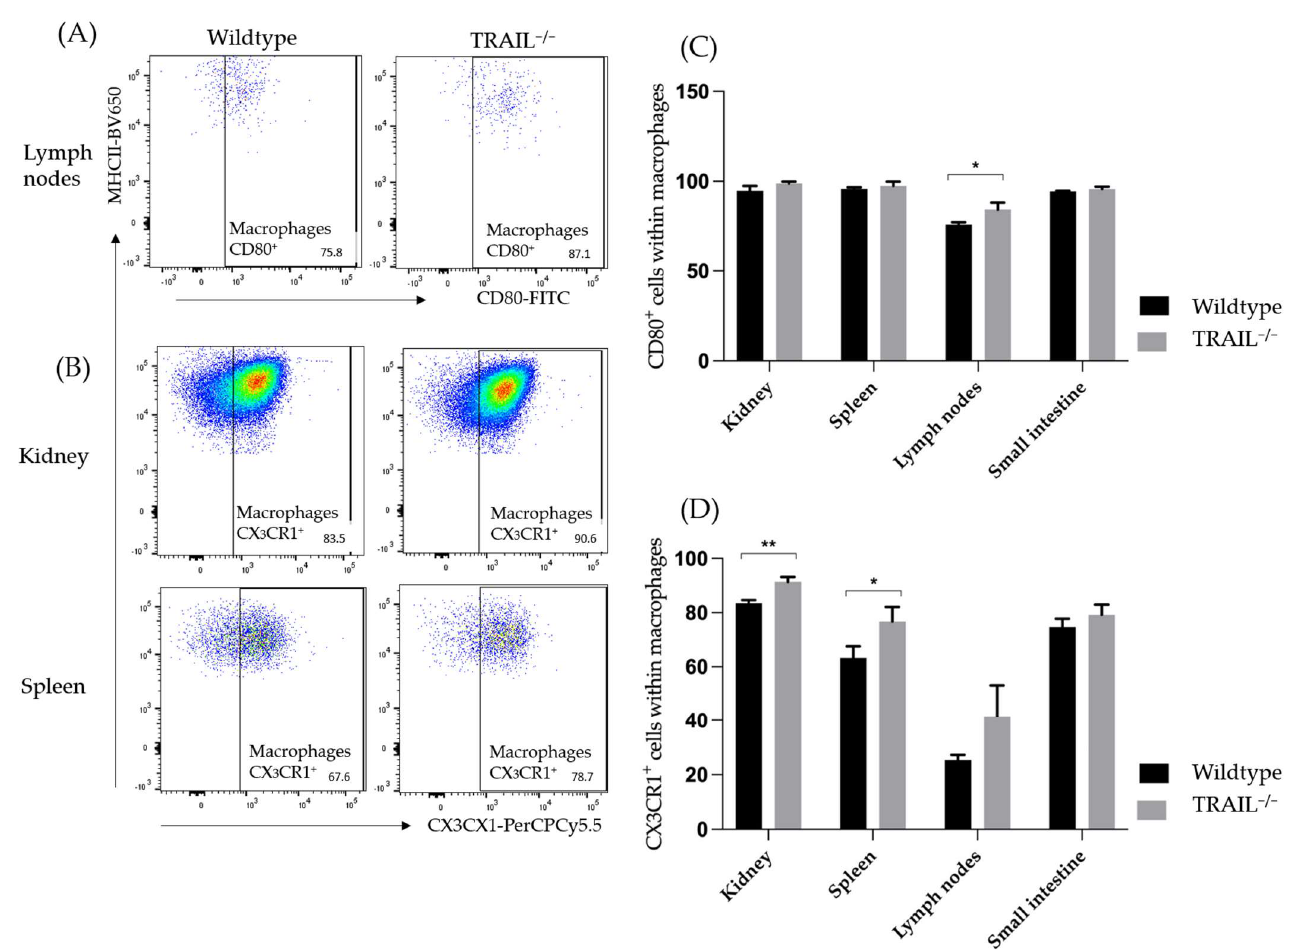
Figure 3. Distribution of CD80 + ( A ) and CX 3 CR1 + ( B ) macrophages in the lymph nodes, kidney, and spleen of TRAIL −/− mice versus wildtype C57BL/6 mice. ( A , B ) Exemplary dot plot illustrate the CD80 ( A ) and CX 3 CR1 ( B ) expression on macrophages in the kidney, spleen, and lymph nodes of TRAIL −/− mice versus wildtype C57BL/6 mice. ( C , D ) Histogram compares means ± SEM of all CD80 + ( C ) and CX 3 CR1 + ( D ) macrophages in the kidney, spleen, lymph nodes, and small intestine (( C , D ) Mann-Whitney test, n = 6 per group, * p < 0.05, ** p < 0.01).